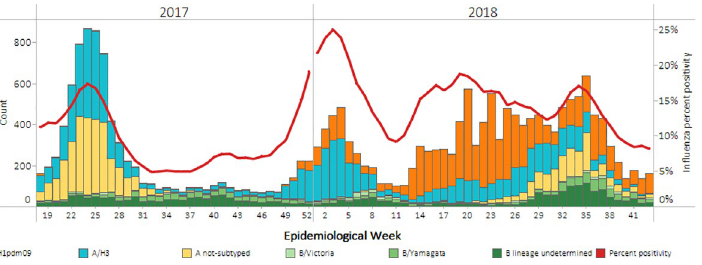
Fig 1. Patterns of influenza circulation among selected countries in Latin America a , epidemiologic weeks 18, 2017 through 43, 2018. a Argentina, Brazil, Chile, Colombia, Costa Rica, Ecuador, Mexico, Paraguay, Peru, and